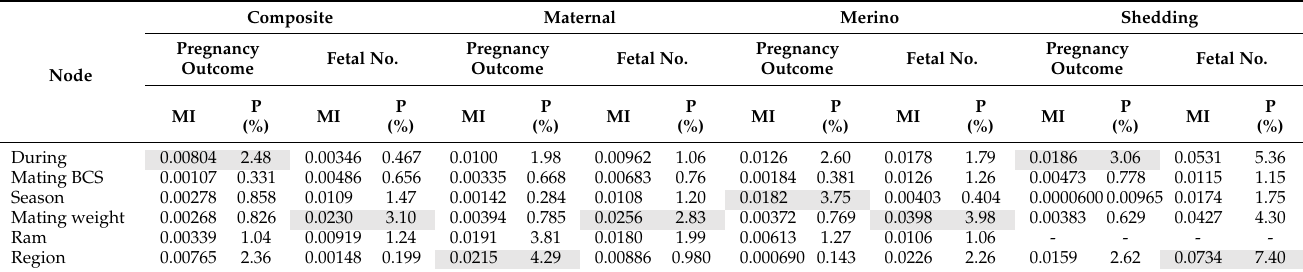
Table 3. Bayesian network sensitivity analysis to determine how much the pregnancy outcome and fetal number (no.) nodes were influenced by each of the observed nodes within each breed, Composite, Maternal, Merino, shedding. Fetal number is for positive pregnancy outcomes (‘1’ was selected in pregnancy outcome node (variable) and the fetal number (‘litter size’) sensitivity analysis performed, Figure 1). Mutual information is represented by MI and percentage by P (%). Data displayed to three significant figures (rather than decimal places). Shaded numbers indicate the node which most influences Pregnancy outcome and Fetal number for each breed, a dash (-) indicates no data for